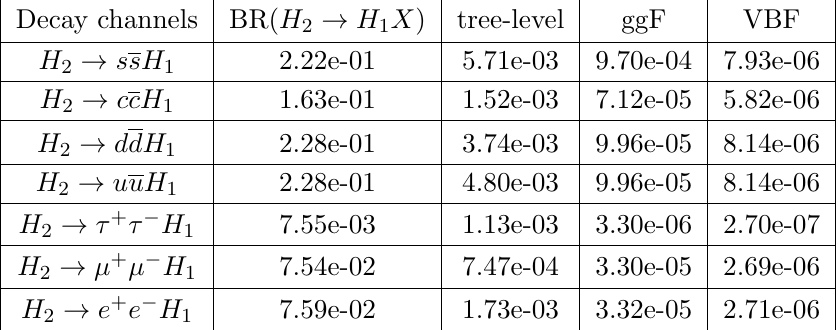
Table 3 . BR and cross section (in pb units) for di(cid:11)erent processes for m DM =54 GeV in scenario I5.